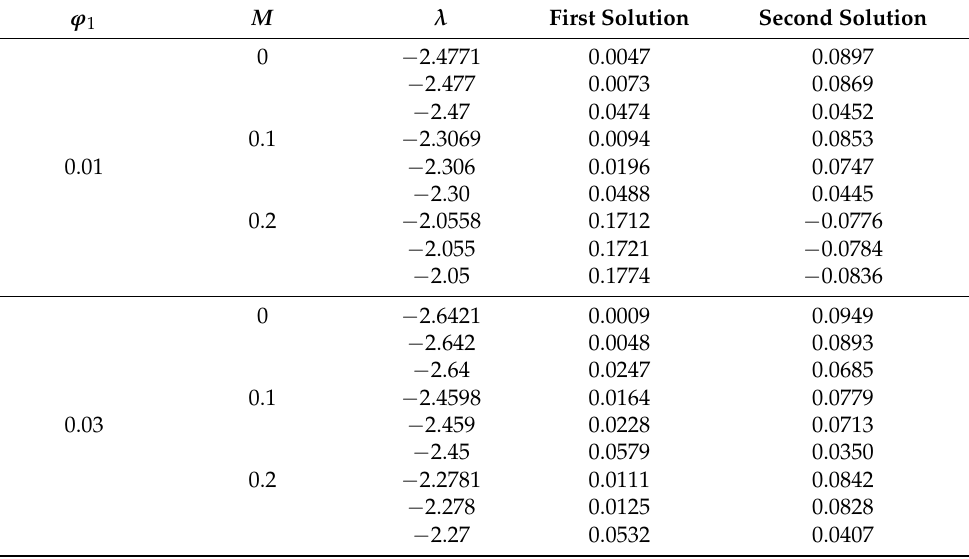
Table 4. Least eigenvalues γ for selected ϕ 1 with several values of M when ϕ 2 = 0.01, Υ = 0.2, ε = − 0.2 and Nr =